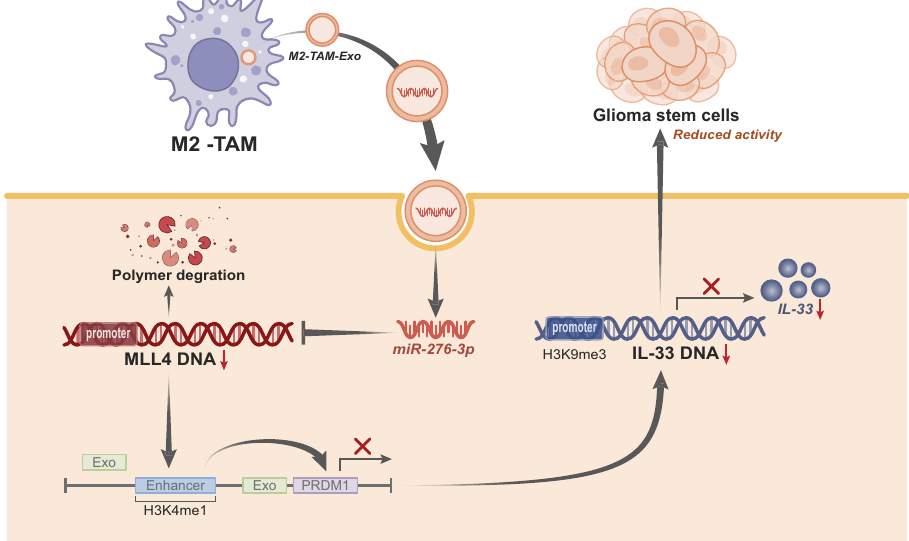
Fig. 7 A molecular mechanism map illustrating the involvement of M2-TAM-derived exosomal miR-27b-3p in the properties of GSCs. M2- TAM-derived exosomal miR-27b-3p targets MLL4 and upregulates the PRDM1/IL-33 axis, thereby promoting the properties of